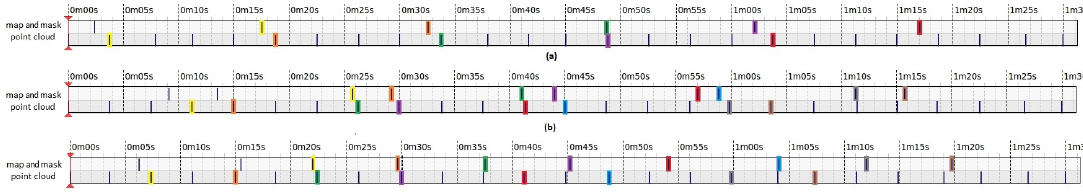
Figure 13. Output rate for the 3D point cloud, FEM and FRM using the current 3D point cloud with one Map node ( a ), two Map nodes without forced spacing ( b ) and two Map nodes with one forced spacing ( c